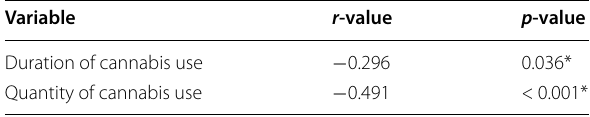
Table 2 Substance use pattern of study subjects